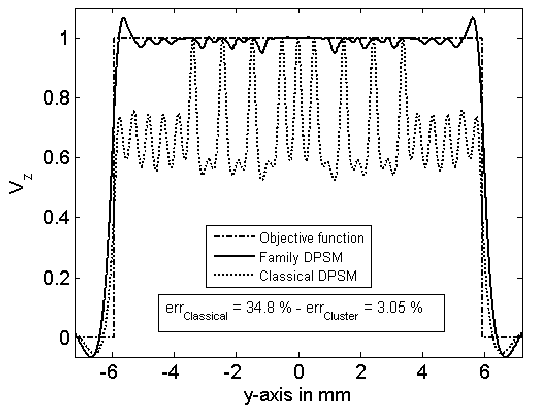
Figure 6. The normal velocity variation on the transducer surface: dashed-dotted line—true value; solid line—computed results using source clusters, as shown in Figure 3; and dashed line—computed by superimposing individual point source contributions, as shown in Figure